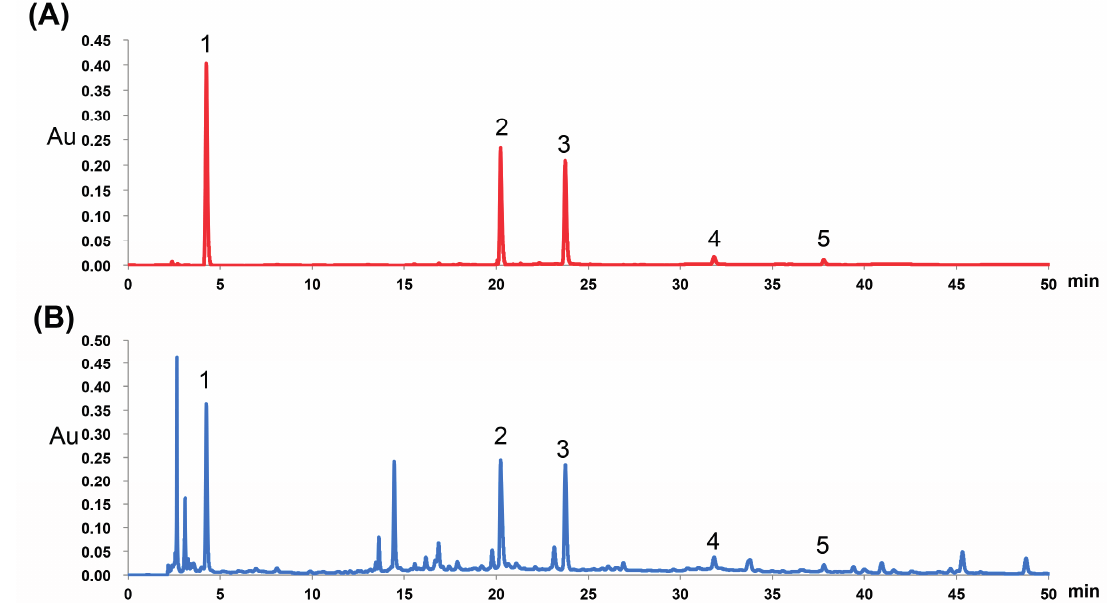
Figure 1. Representative HPLC-UV chromatograms of mixed standards ( A ) and P. chinense extract ( B ). Gallic acid (1), isoquercitrin (2), quercitrin (3), quercetin (4) and kaemferol